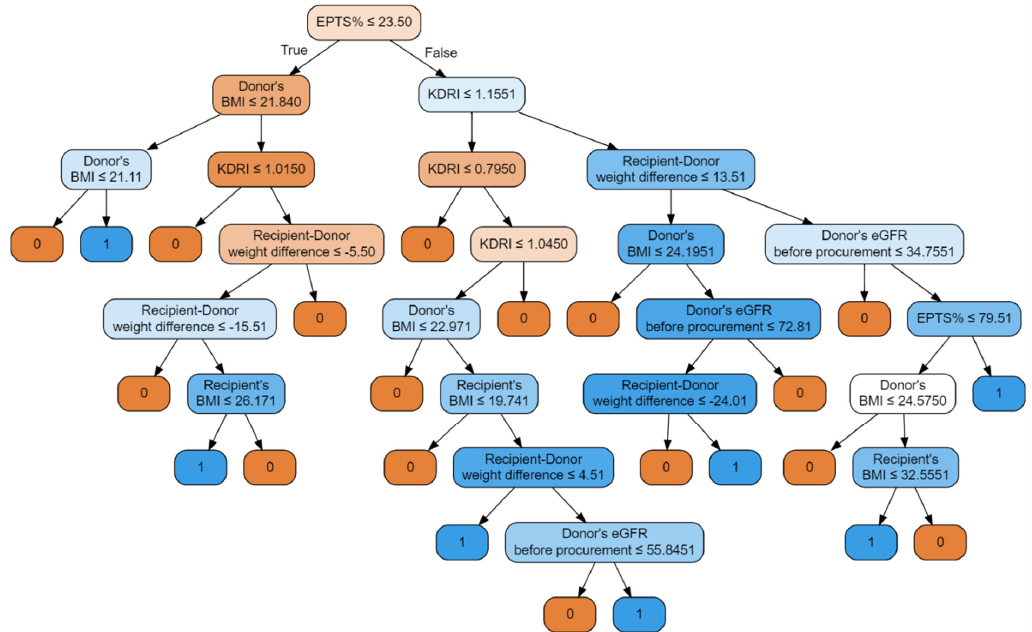
Figure 5. Random forest classifier with input features including six parameters: donor’s BMI, donor’s eGFR before procurement, EPTS, KDRI, recipient–donor weight difference, recipient’s BMI. The model has 4 input parameters that are also significant for the previous model.